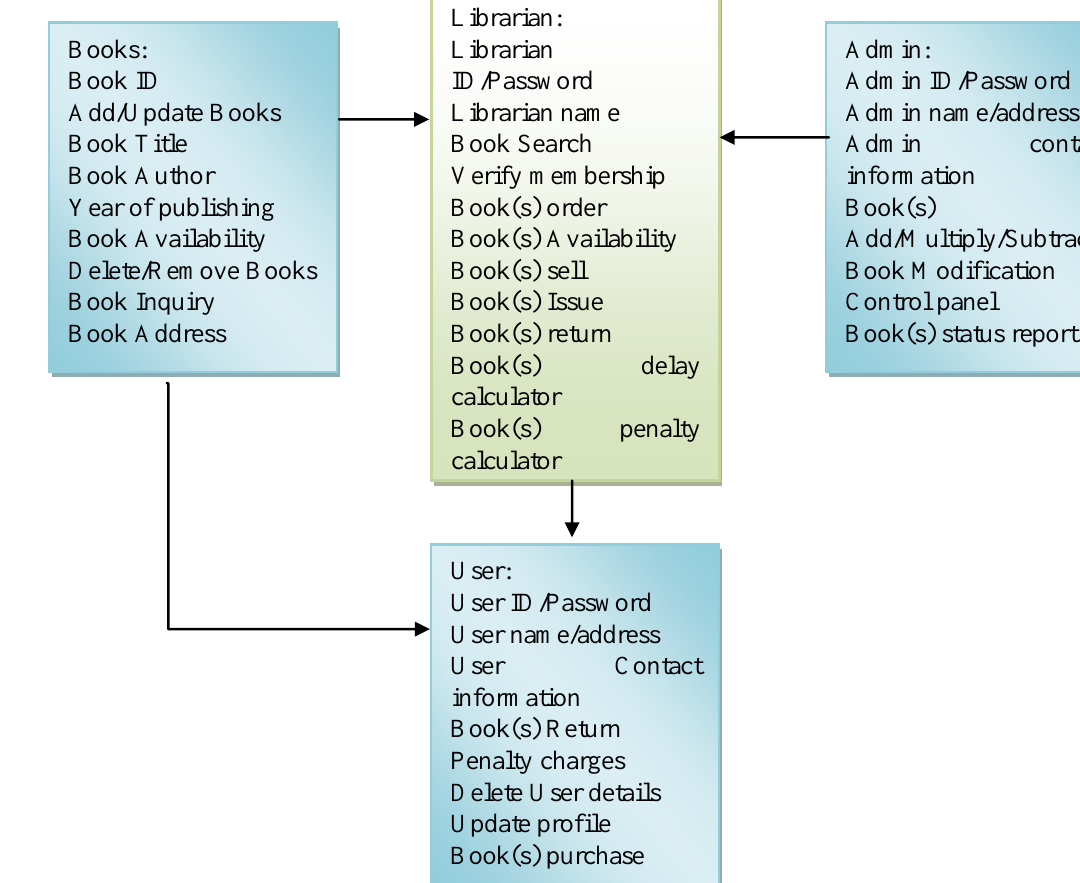
Figure 3. Designed of library management